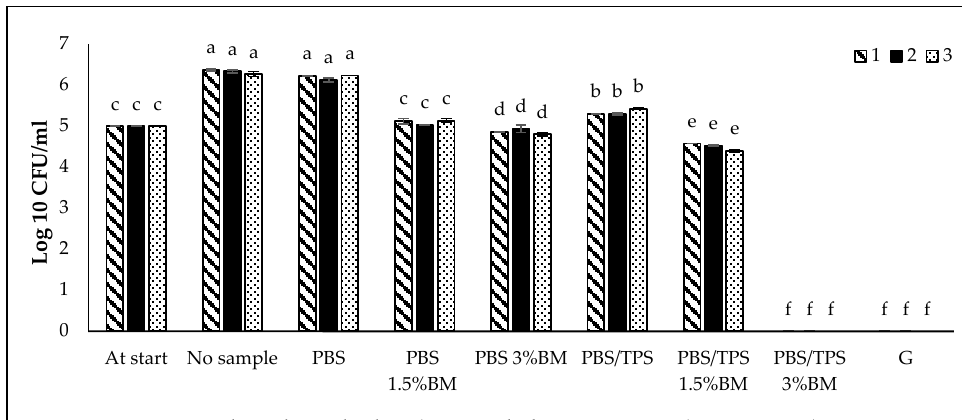
Figure 6. Schematic diagrams of ( a ) PBS, ( b ) PBS/BM, ( c ) PBS/TPS, and ( d ) PBS/TPS BM films in response to the penetration of oxygen and water.